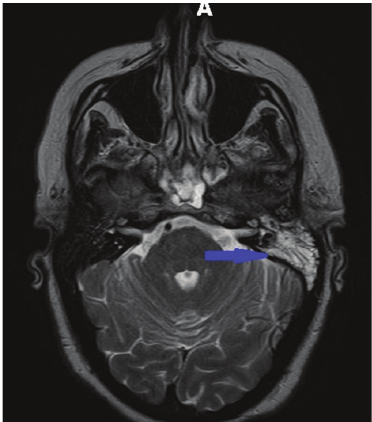
Figure 3: The MRI shows enhancement in the temporal bone region equivocal for inflammation and infection (blue